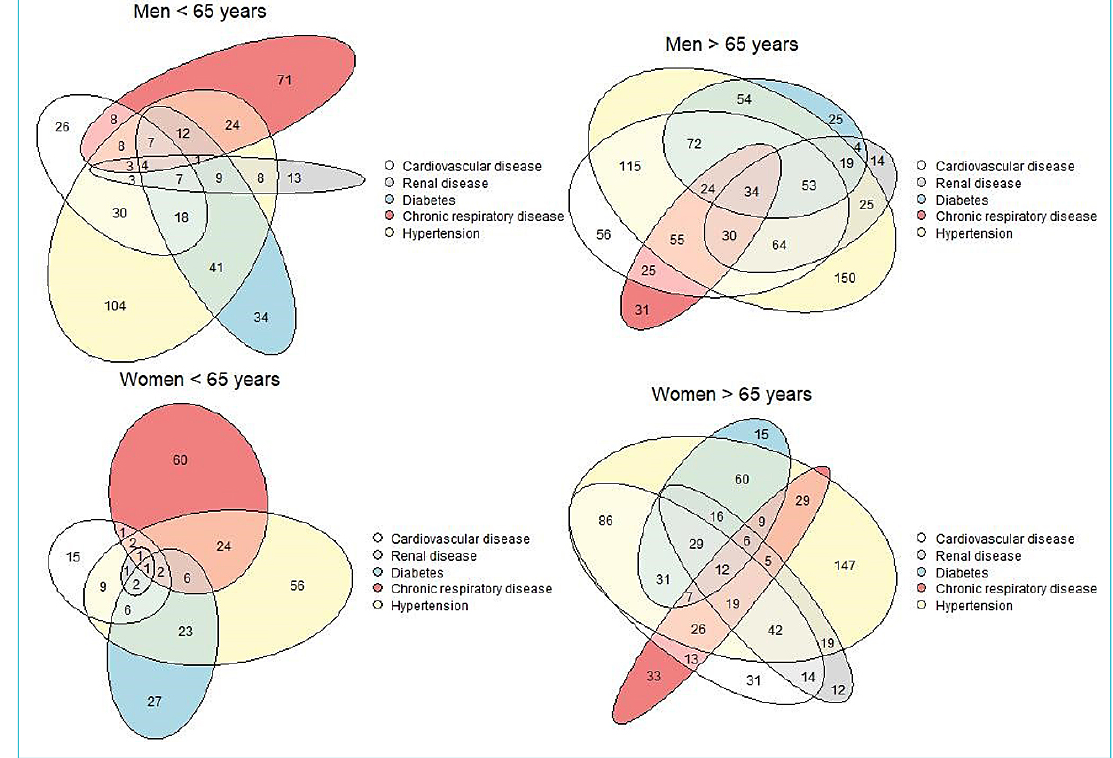
Figure 1: Scaled Euler diagrams by age and gender showing the overlap of the five most common comorbidities for 3590 adult patients hospi- talised for COVID-19 in Switzerland. Data included up to 1 September 2020 (date of extraction 15 January 2021). Missing values have been